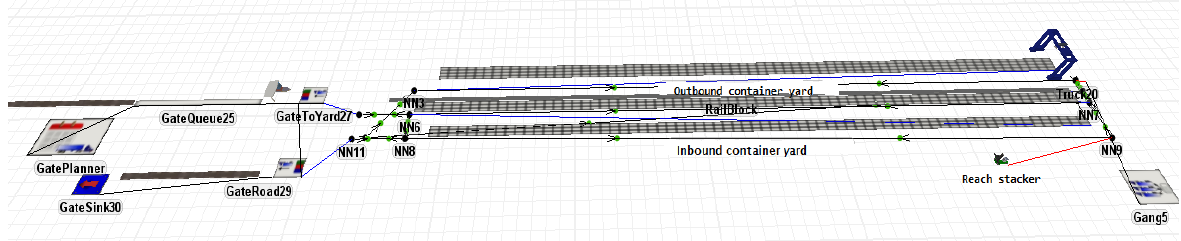
Figure 4. Layout of the inland terminal in the FlexSim CT simulation to validate the mathematical model for inbound container placement.